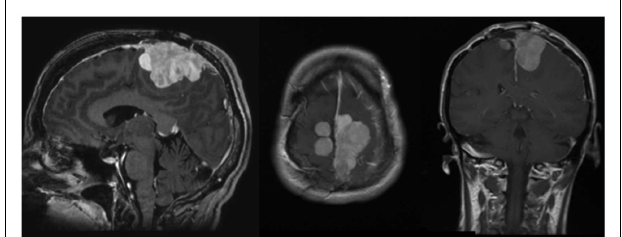
FIGURE 2 | Pre-operative MRI . MRI (l–r, sagittal, axial, coronal) demonstrates an avidly enhancing, complex falcine meningioma involving both sides of the superior sagittal sinus.